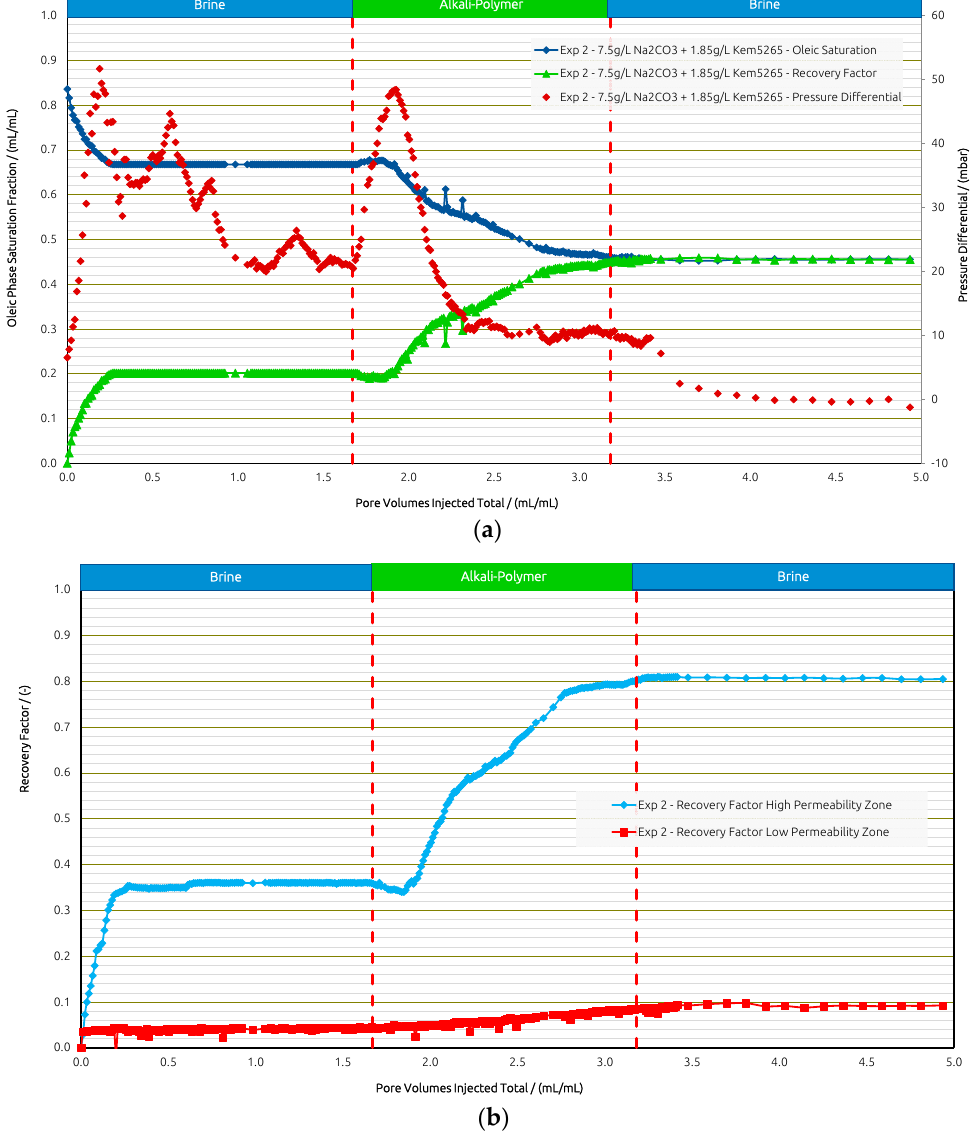
Figure 11. Summary of results obtained for Exp. 2 in micromodel experiments. ( a ) Oleic saturation, Recovery Factor (RF), and pressure differential for the entire chip and ( b ) RF of low-permeability zone vs. RF of high-permeability zone.